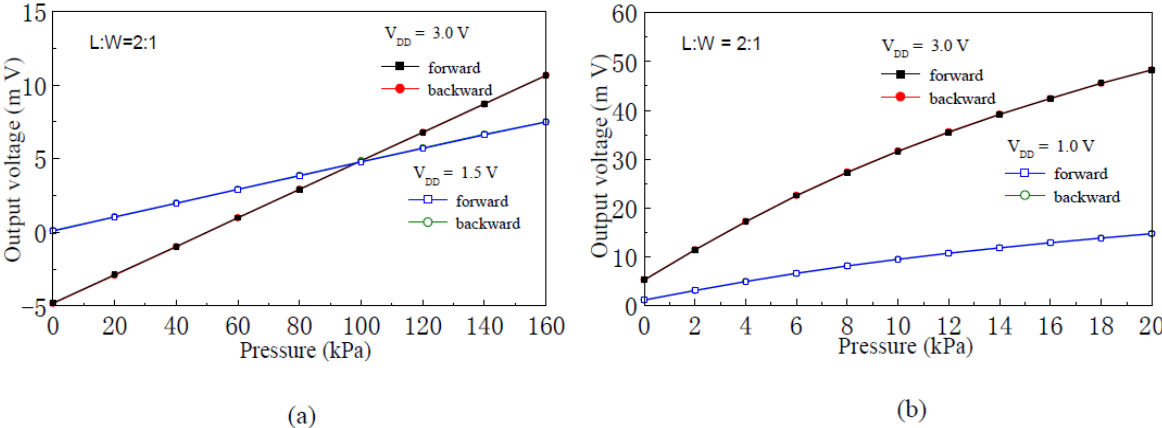
Figure 10. Hysteresis experimental curves of the nc-Si/c-Si heterojunction MOSFETs pressure sensor. ( a ) Membrane thickness 75 μ m; ( b ) Membrane thickness 45 μ